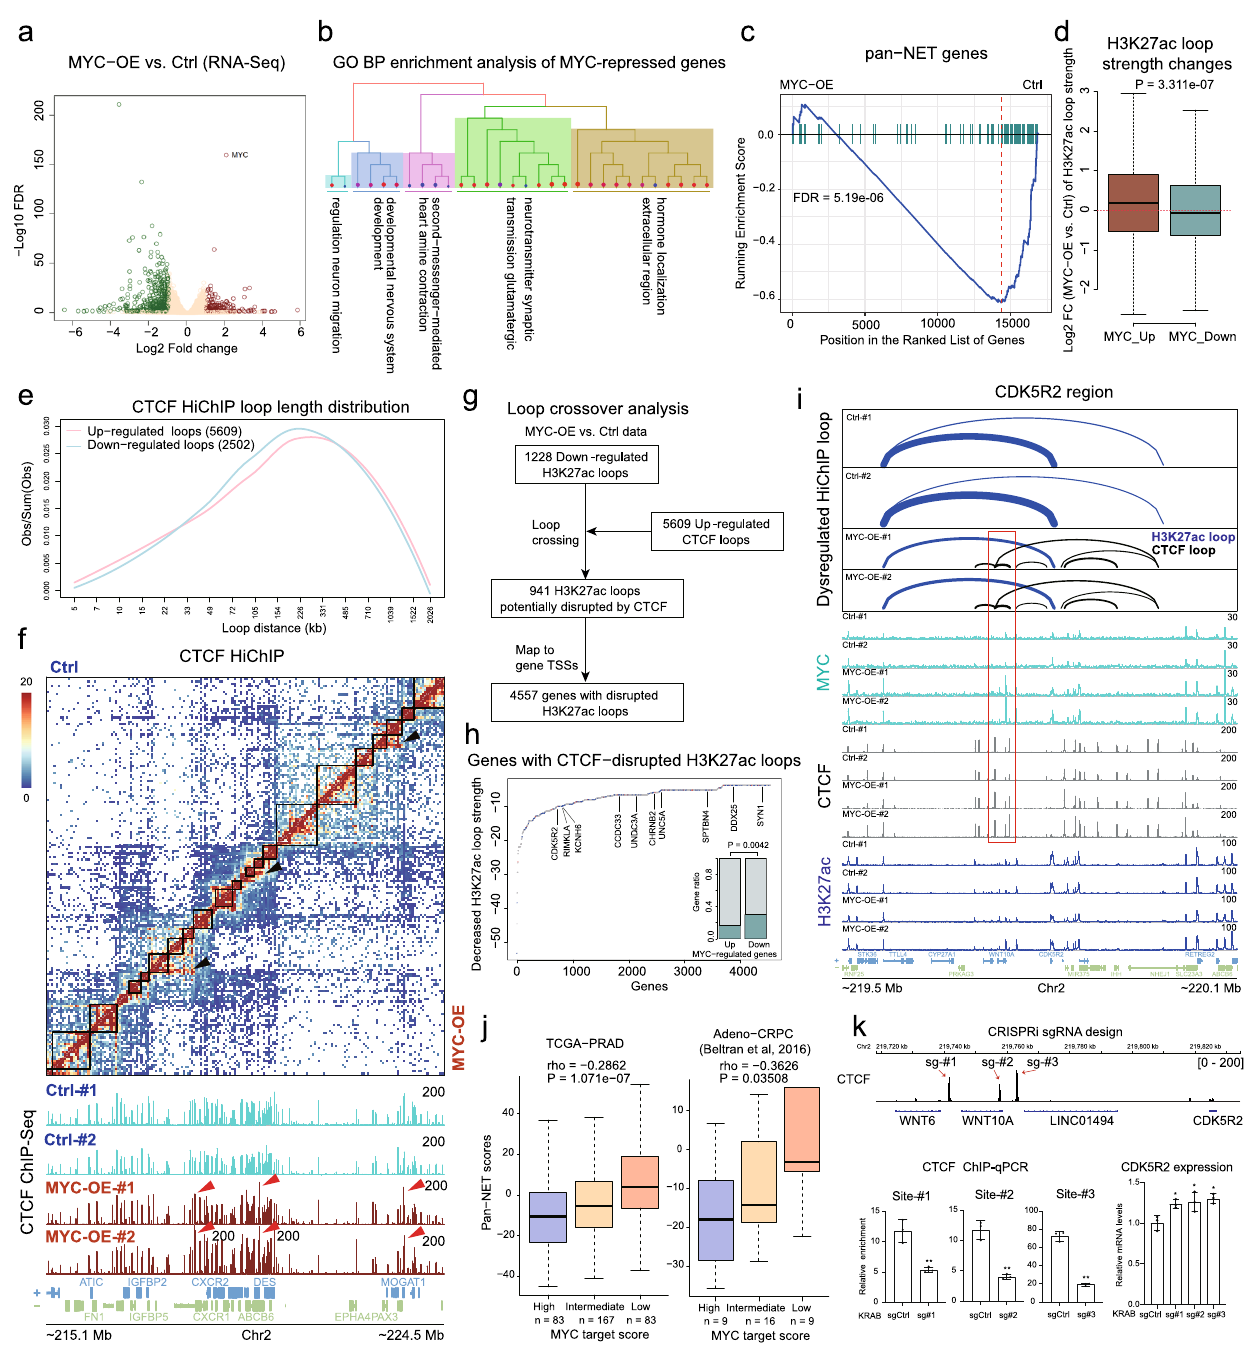
Fig. 5 | MYC represses neuroendocrine genes by promoting CTCF looping. a Volcano plotshowing dysregulatedgenes by MYC overexpression. n =2. b GO BP enrichment analysis of 479 MYC-repressed genes. The GO terms with high simi- laritywereclusteredtogetherandsummarized. n =2. c GSEAplotshowingthepan- NET genes were overall suppressed by MYC overexpression. d Boxplots showing H3K27ac loop strength fold changes at the promoters of upregulated or down- regulated genes after MYC overexpression. Box plots indicating the mean (middle line), 25th and 75th percentile (box) and 10th and 90th percentile (whiskers). n =854, 5024 from left to right, respectively. P-value was determined by Student ’ s t-test. e The length distribution of CTCF loops dysregulated by MYC. f Normalized CTCF HiChIP contact matrices of Ctrl and MYC-OE cells at a genomic region of chromosome 2. The black rectangles indicate TAD structures. Black arrows high- light the intra-TAD CTCF looping enhanced by MYC. Red arrows highlight the correspondingCTCFbindingincreasedbyMYC. g Theanalysiswork fl owtoidentify genes with H3K27ac loops disrupted by increased CTCF looping after MYC over- expression. h Ranked dot plot showing the decreased H3K27ac loop strength